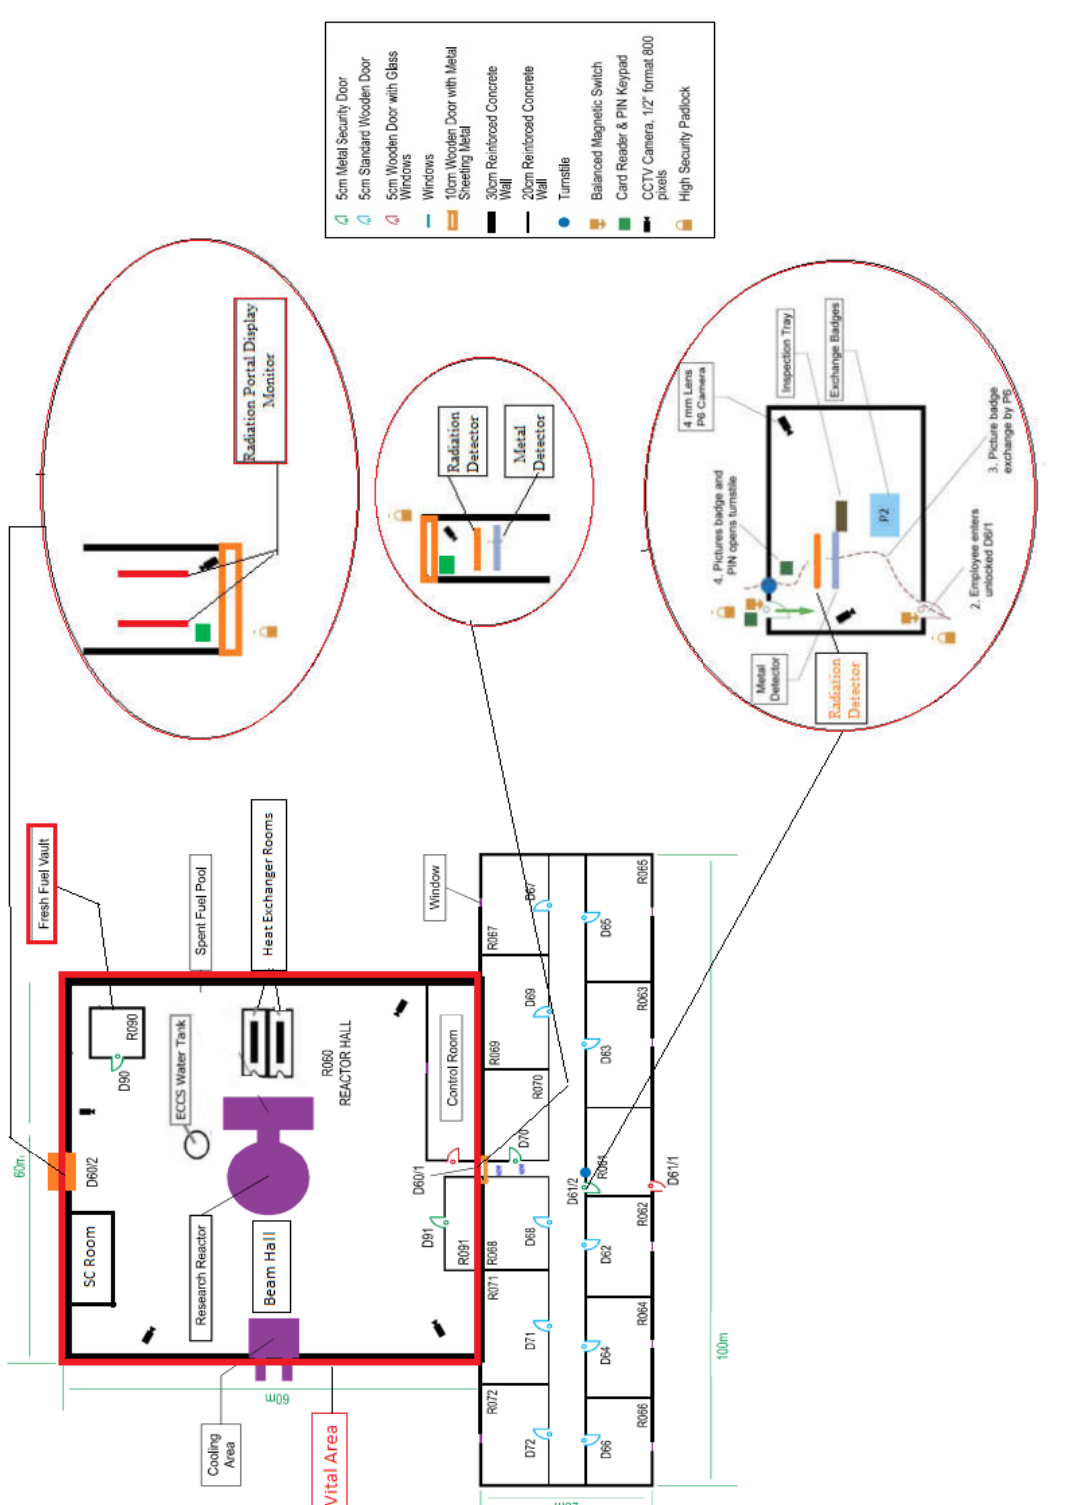
Figure 17. The new MTR wall thicknesses and access control plan.